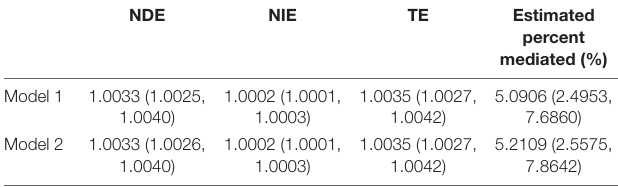
TABLE 3 | Mediation analysis of NLR on associations of UA with ischemic stroke